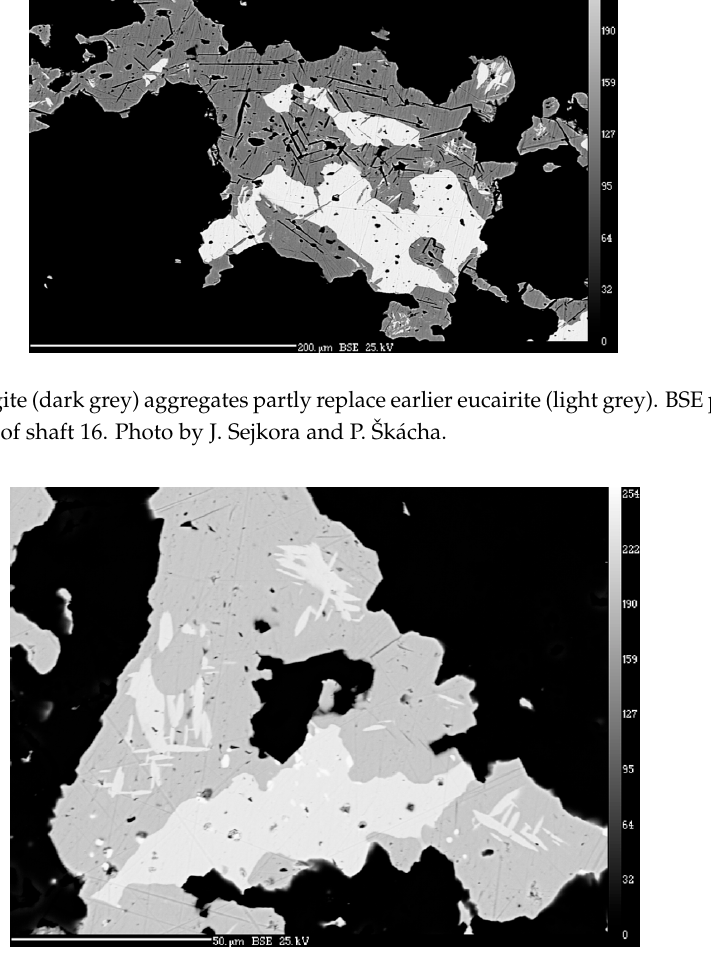
Figure 36. Berzelianite (grey) replaces earlier eucairite aggregates (white). BSE photograph. P ř íbram, a dump of shaft 16. Photo by J. Sejkora and P. Škácha.